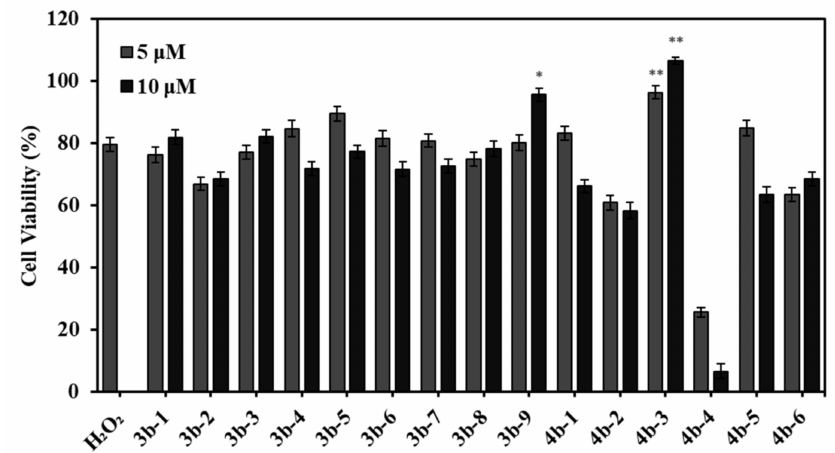
Figure 2. 3b-9 and 4b-3 reverses oxidative damage in HaCaT cells. HaCaT cells were incubated with different concentration of 3b-9 and 4b-3 (5 and 10 µ M) for 24 h and then were treated with H 2 O 2 for 3 h. The cell viability was determined by the SRB method. Values are expressed as mean ± SD of three independent experiments. * p < 0.05, ** p < 0.01, versus H 2 O 2 group.